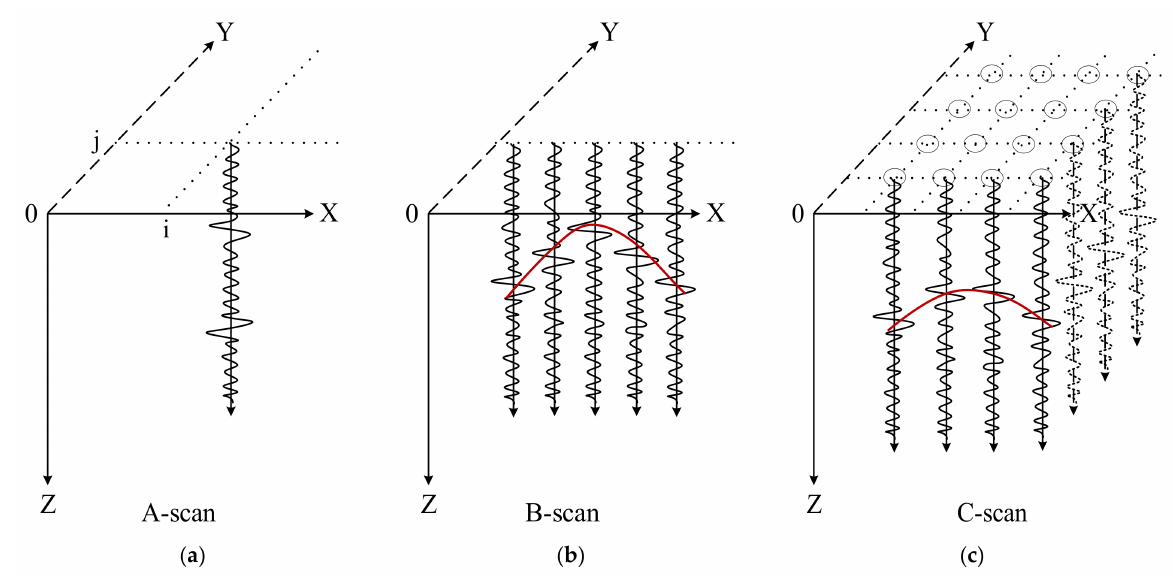
Figure 2. Types of GPR radargrams’ visual presentations: ( a ) A-scan; ( b ) B-scan; ( c ) C-scan.